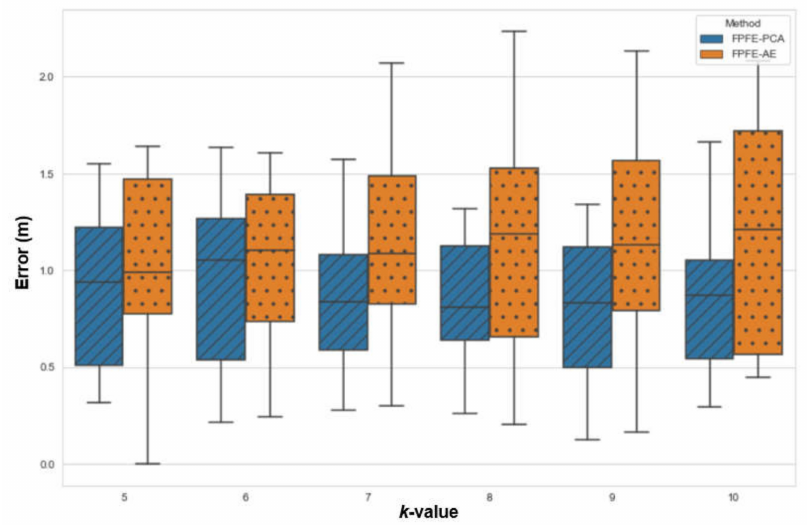
Figure 15. The localization error box and whisker plots of FPFE with 93 grid RPs for k RP candidates, where k = 5, 6, 7, 8, 9, and